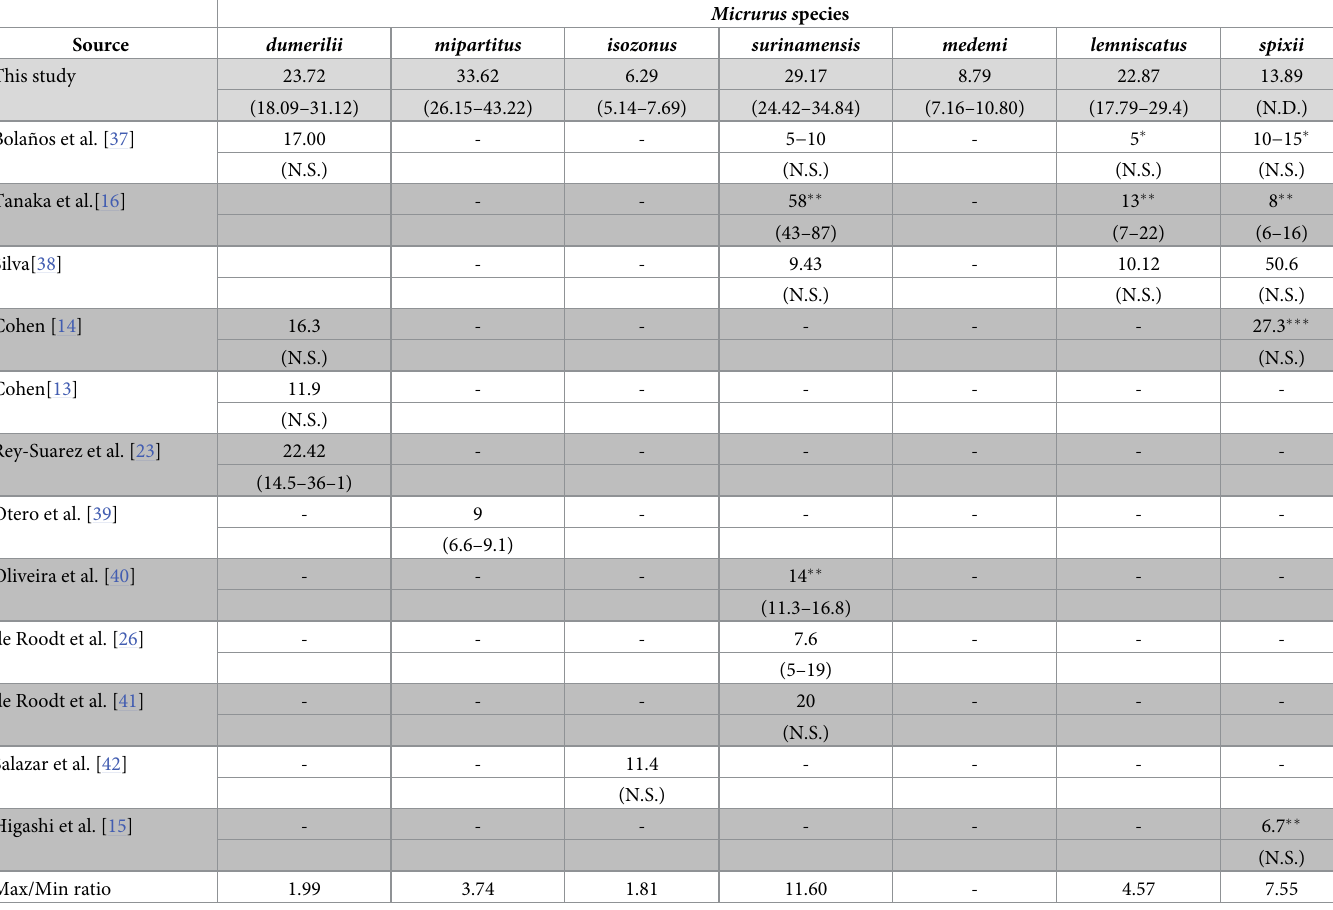
Table 1. LD 50 values from Micrurus venoms studied herein, compared with literature